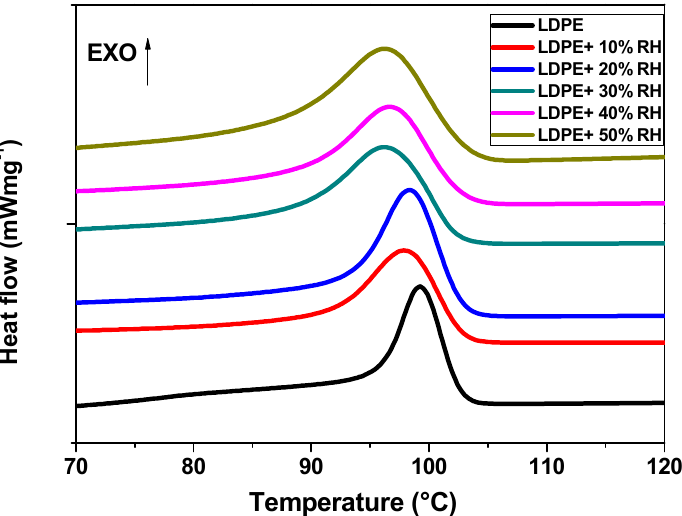
Figure 11. Crystallization behaviour of the neat LDPE and LDPE/RH biocomposites recorded during cooling by 10 °C/min. Table 5. Results of DSC measurement for the neat LDPE and LDPE/RH biocomposites.